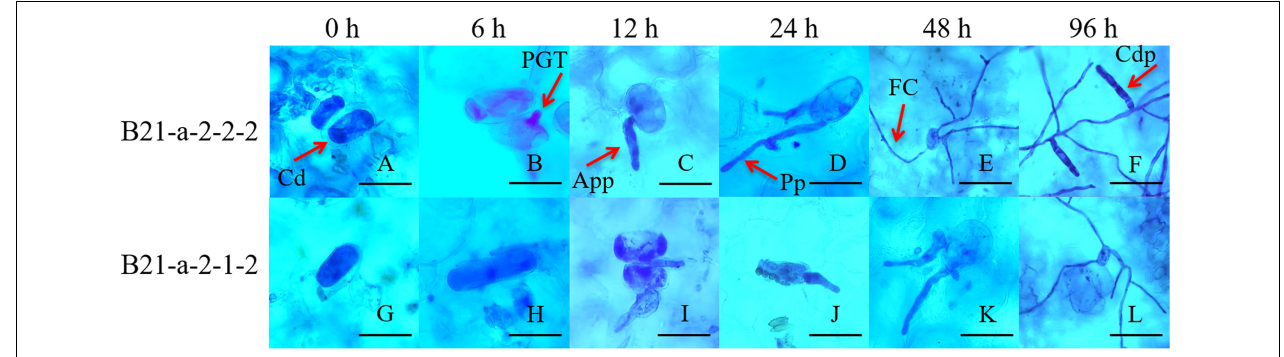
FIGURE 1 | Process of infection of P. xanthii of the PM-susceptible cucumber strain B21-a-2-2-2 and the PM-resistant cucumber strain B21-a-2-1-2. Cd, conidia; PGT, primary germ tube; App, appressorium; Pp, penetration peg; FC, fungal colony; Cdp, conidiophore. The bar in panels A through D and G through K is 20 µ m, and the bar in panels E through F and L is 60 µ